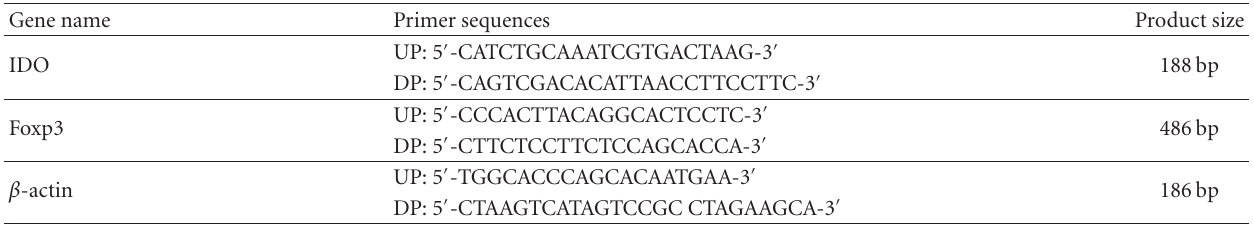
Table 1: Primers for real-time quantitative